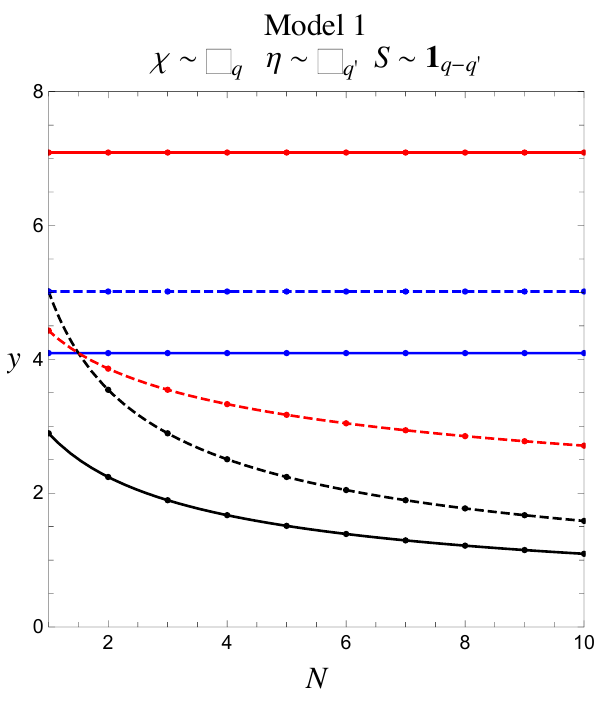
Figure 1 . PU bounds on the Yukawa couplings y for the model 1 of the Dirac type class for J = 0 (black), J = 1 / 2 (blue) and J = 1 (red). The solid (dashed) lines correspond to the case of a real (complex) scalar